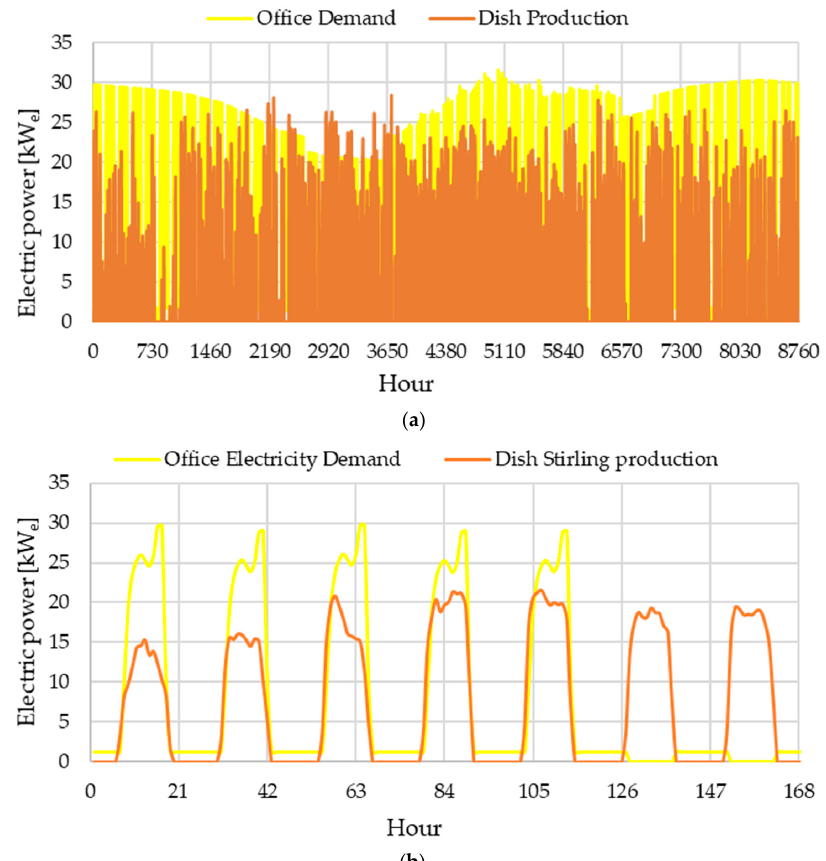
Figure 9. Scenario no. 1-A: ( a ) profiles of annual electricity demand and dish-Stirling production and ( b ) weekly profiles of electricity demand and dish-Stirling production.